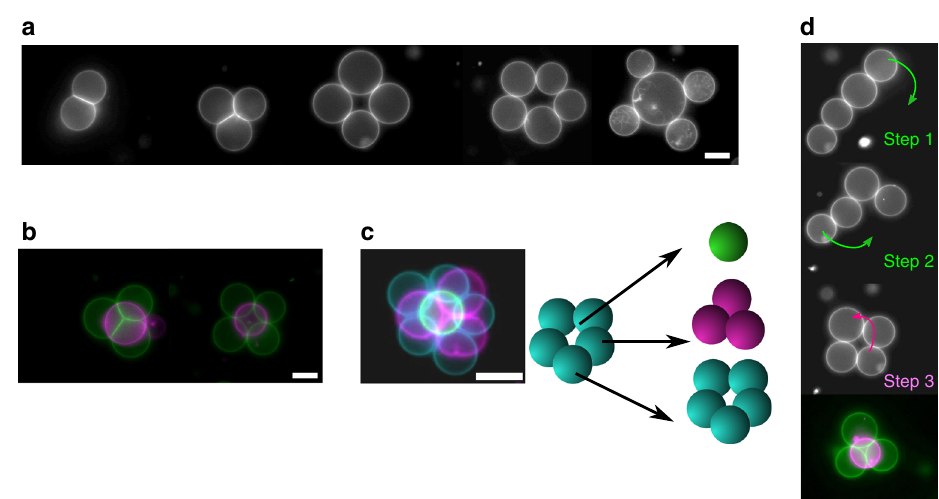
Fig. 2 Controlled and recon fi gurable assembly of vesicle networks. a A de fi ned number of vesicles were brought together to assemble 2-D networks of various architectures, including, from left to right, bi-compartment, trigonal, square, pentagonal and branched geometries. b Vesicles were vertically manipulated and deposited enabling 3-D structures to be assembled, including tetrahedral and square-pyramidal geometries. c Three-layered pyramid geometries could also be formed, with the vesicle arrangements shown in schematic on the right. d Optical tweezers were used to recon fi gure the networks between several geometries (linear to square to tetrahedral; arrows indicate direction of movement). False colours used to demonstrate that images were taken in different planes and subsequently superimposed. Green channel = lower plane; pink channel = upper plane. Scale bar = 10 µ m for all images. NaCl concentration = 0.75